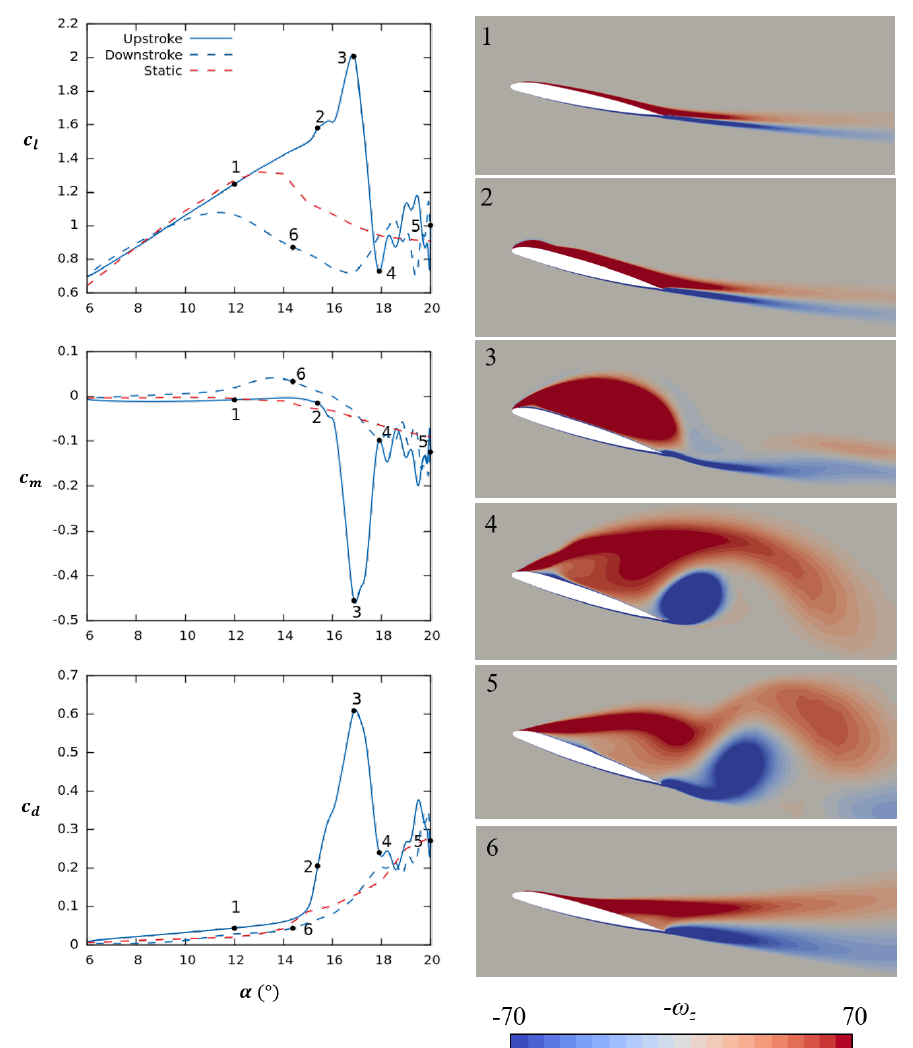
Figure 1. Static and dynamic stalls of OA209 airfoil at Ma = 0.3, Re = 1.15 × 10 6 and k =